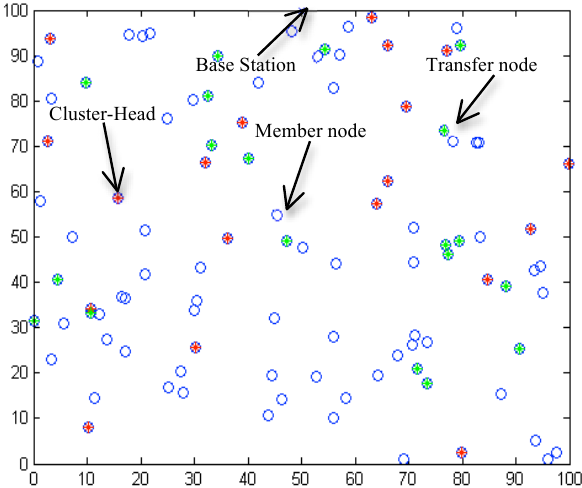
Fig. 2. Random distribution of 100 sensor nodes with